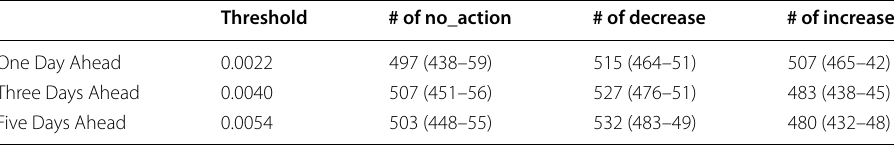
Table 16 Extended data set statistics (training and test